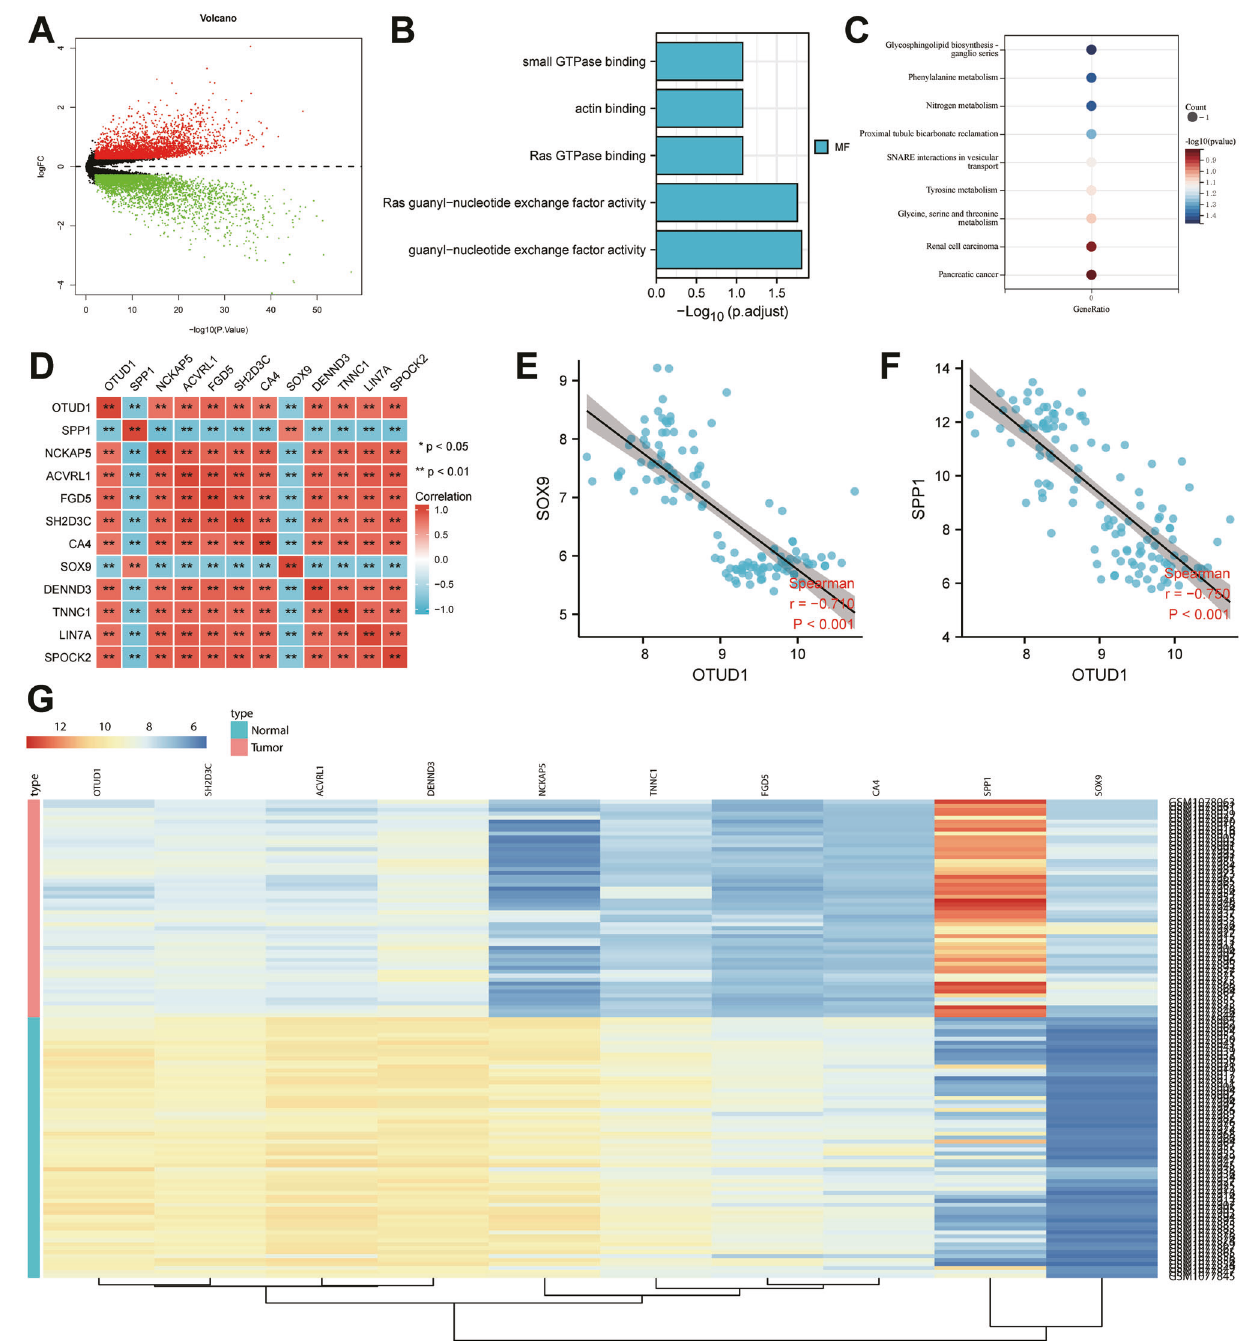
Fig. 1 Prediction of the DEGs and their molecular interactions in NSCLC. A A volcano map of the results from differential analysis of the GSE44077 dataset. Red dots represent upregulated genes, green dots represent downregulated genes and black dots represent un- differentially expressed genes. B GO analysis of the top 50 DEGs screened from the GSE44077 dataset. C KEGG enrichment analysis of the top 50 DEGs screened from the GSE44077 dataset. D Correlation analysis heat map of the top 10 DEGs screened from the GSE44077 dataset. E Correlation analysis of OTUD1 and SOX9 in the GSE44077 dataset. F Correlation analysis of OTUD1 and SPP1 in the GSE44077 dataset. G A heat map of the expression of the top 10 differential genes in the GSE44077 dataset. The color scale from green to red indicates the expression level of genes from low to